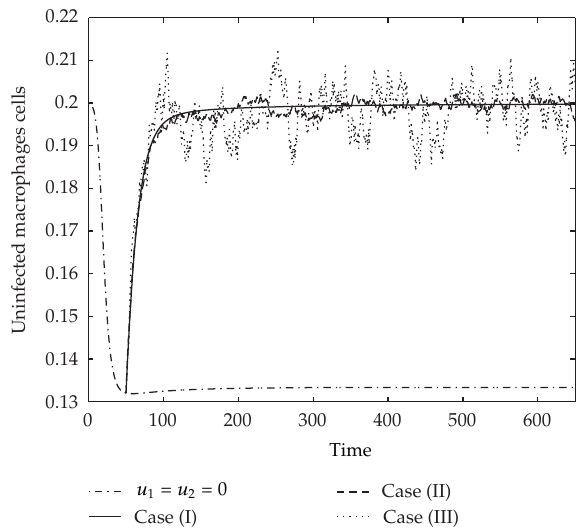
Figure 3: The evolution of uninfected